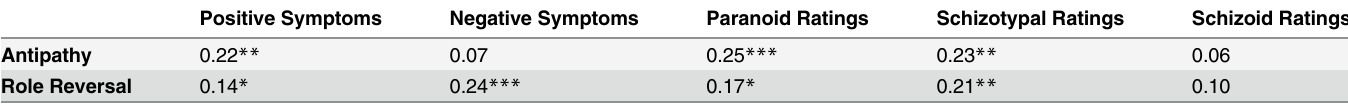
Table 2. Partial Correlations of Antipathy and Role Reversal with Schizophrenia-Spectrum Phenomenology. Positive Symptoms